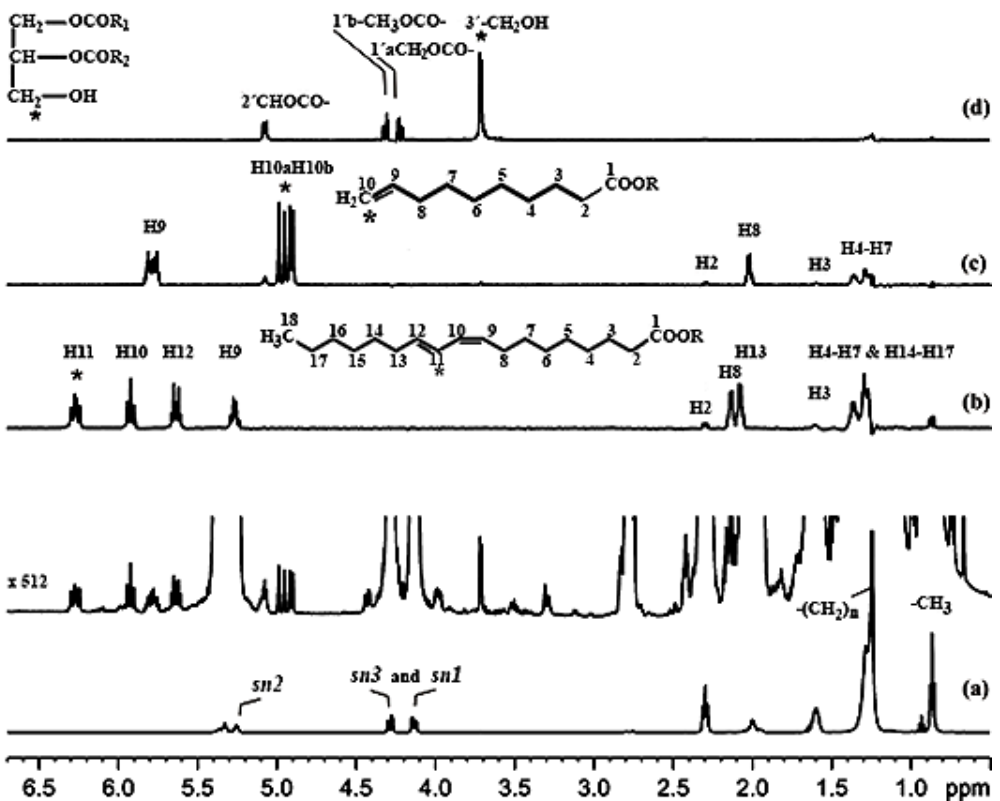
Figure 28. Spin chromatogram of the lipid fraction of a lyophilized cheese sample in CDCl 3 . ( a ) 500 MHz 1 H-NMR spectrum of the lipid fraction of a lyophilized cheese sample in CDCl 3 (T, 298 K; number of scans, 256; acquisition time, 4.3 s; relaxation delay, 5 s; and total experiment time, ~25 min). The major lipid resonances are denoted ( sn 1, sn 2, and sn 3 indicate the stereospecific numbering of esterified glycerol). The inset shows 512× magnification of the spectrum to display resonances from the 18:2 CLA and other minor species. ( b – d ) 1D TOCSY spectra of panel with τ m = 400 ms (number of scans, 256; and total experiment time, ~25 min). The asterisks denote the resonances that were excited by the use of a selective pulse. Adopted, with permission, from [78]. Copyright 2015, American Chemical Society. Table 21. Results obtained using 1D TOCSY NMR, conventional 1 H-NMR and GC-MS methods for the determination of the caproleic acid in two milk samples. Reprinted, with permission, from [78]. Copyright 2015, American Chemical Society.